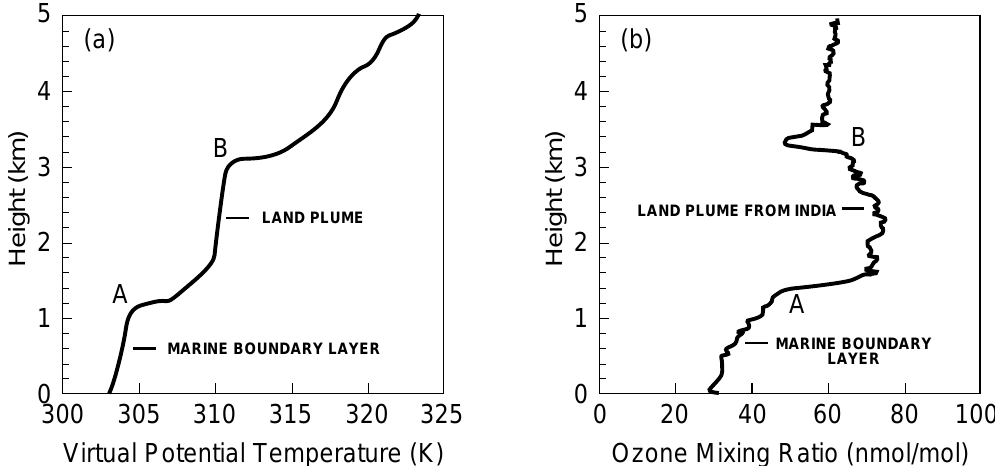
Fig. 17. Example of (a) the temperature profile showing the land plume and (b) the corresponding elevated ozone layer in the land plume, based on balloon soundings from the RV Ronald H. Brown on 7 March 1999, at 11.3 ◦ N and 68.3 ◦ E over the Indian Ocean (figure redrawn from Simpson and Raman, 2004, copyright 2004 by the Springer Verlag, reproduced with permission).